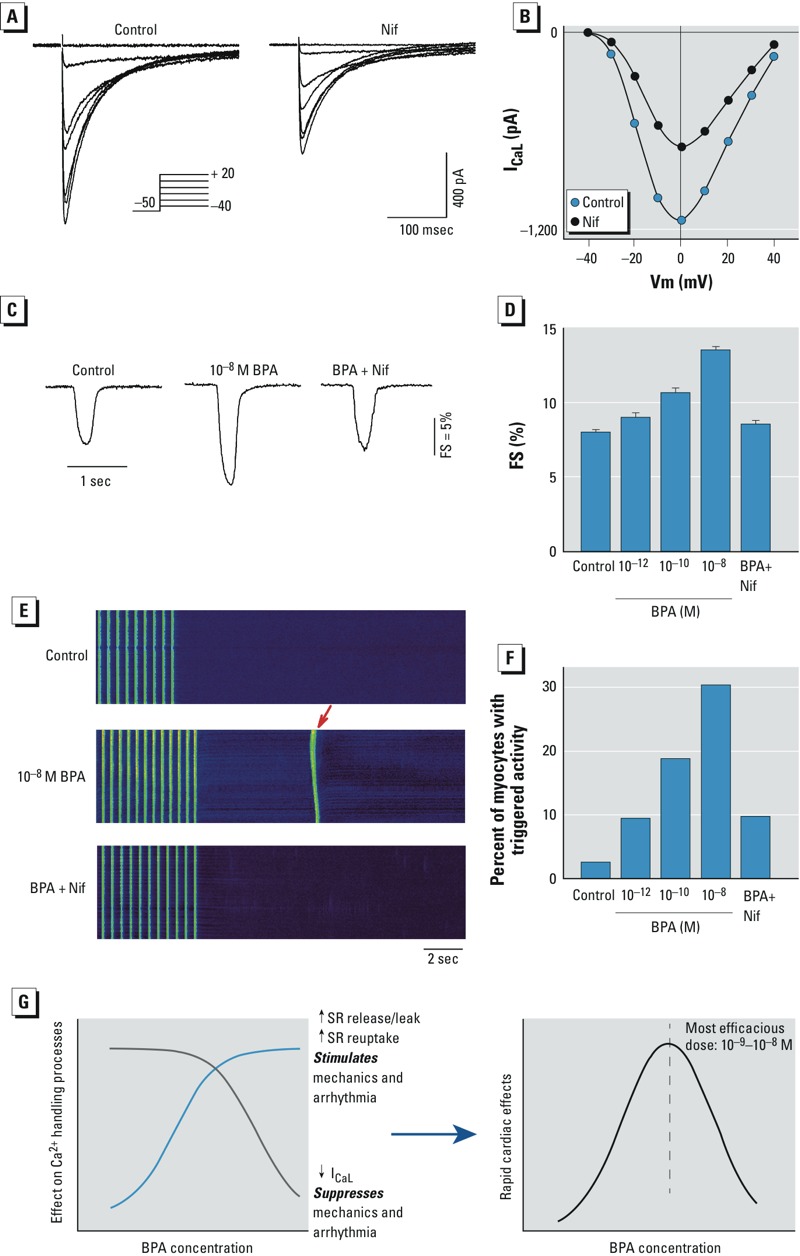
Suppression of ICaL reproduced the nonmonotonic effects of BPA. Current traces (A) and current–voltage relationship (B) showing the blockade of ICaL by 2 × 10–7 M nifedipine (Nif). Inset: voltage clamp protocol. ((C) Representative contraction traces in myocytes exposed to control solution, 10–8 M BPA, and BPA (10–8 M) plus 2 × 10–7 M Nif. (D) Dose-dependent effects of BPA (10–12 to 10–8 M) BPA plus Nif on myocyte fractional shortening (FS); n = 35, 23, 23, 35, and 37 myocytes for control; 10–12, 10–10, and 10–8 M BPA; and BPA plus Nif, respectively. (E) Representative confocal images of Ca2+ transients in female rat myocytes elicited by repeated pacing, after acute exposure to control, BPA, and BPA plus Nif; the arrow indicates triggered activity following pacing. (F) Dose-dependent effects of BPA and BPA plus Nif on incidence of triggered activity; n = 31, 32, 32, 33, 31 myocytes for for control; 10–12, 10–10, and 10–8 M BPA; and BPA plus Nif, respectively. (G) Schematic illustration of the cellular mechanism of the nonmonotonic dose response of BPA in female rat ventricular myocytes.